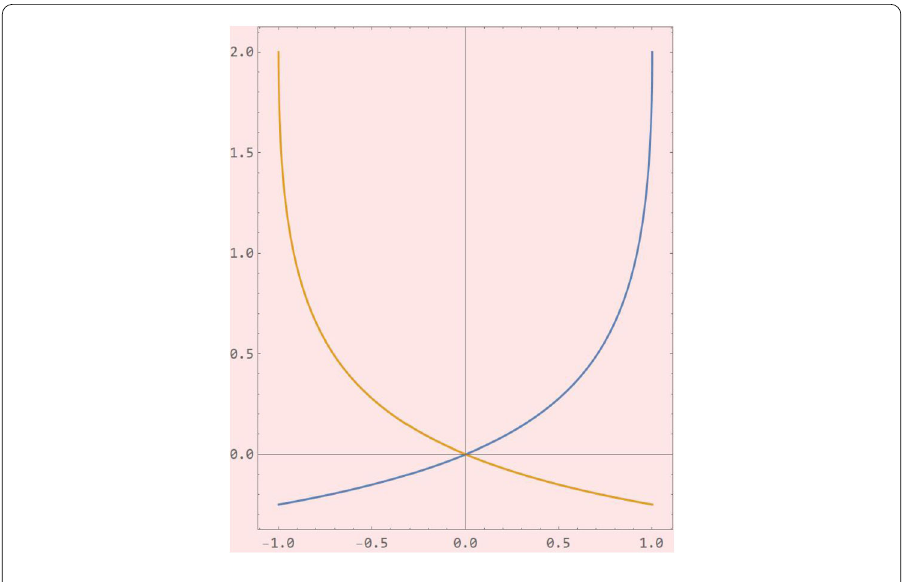
Figure 1 The “ x – y ”